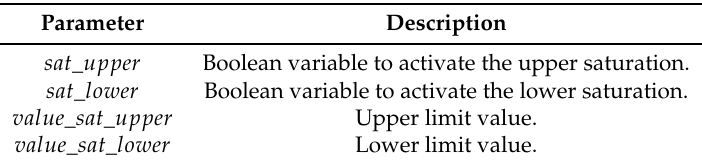
Table A4. Saturation variables.